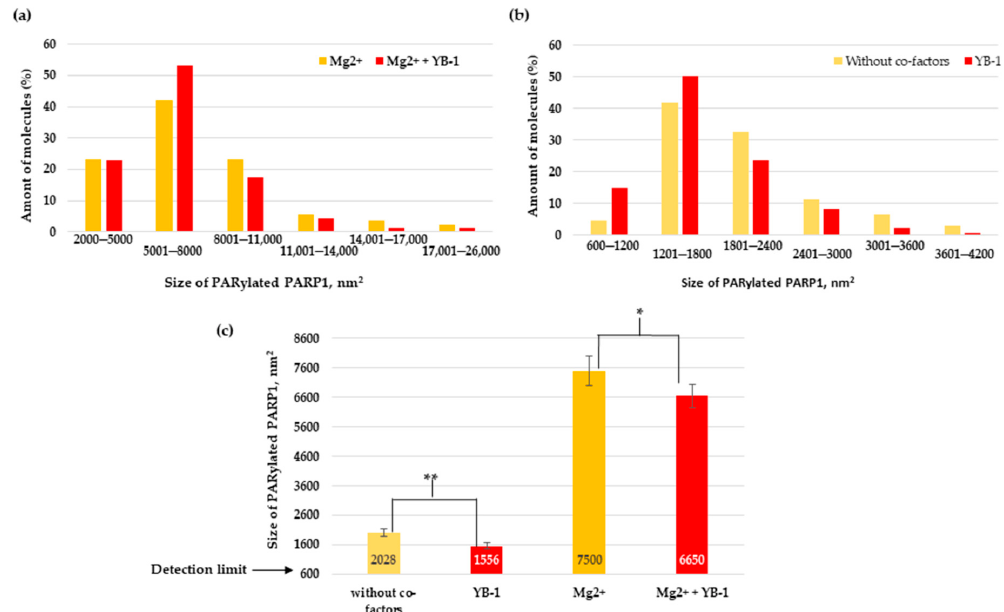
Figure 9. AFM-based analysis of PARylated PARP1 revealing molecular size distributions in the presence of Mg 2+ ( a ), in the presence of Mg 2+ and YB-1 ( a ), without Mg 2+ ( b ), or in the presence of YB-1 without Mg 2+ ( b ). The percentage histograms present the percentage of PARylated molecules in each size range in the presence of Mg 2+ , in the presence of Mg 2+ plus YB-1, without co-factors, or in the presence of YB-1. Numbers of PARylated molecules analysed: 91 in the Mg 2+ group, 81 in group ‘Mg 2+ and YB-1 ′ , 133 in the group without co-factors, and 145 in the YB-1 group. An ellipse with the smallest area whose centre coincided with the centre of a PARylated molecule and completely enclosed it was chosen to estimate the area of the molecules. The sizes of PARylated PARP1 smaller than 600 nm 2 were disregarded. ( c ) The average size of PARylated PARP1 measured in images shown in ( a , b ). Results are mean ± SD of two to five images of three independent samples for each assay group. p -values were obtained by comparing the results by Student’s t-test, *, p < 0.05; **, p < 0.01.